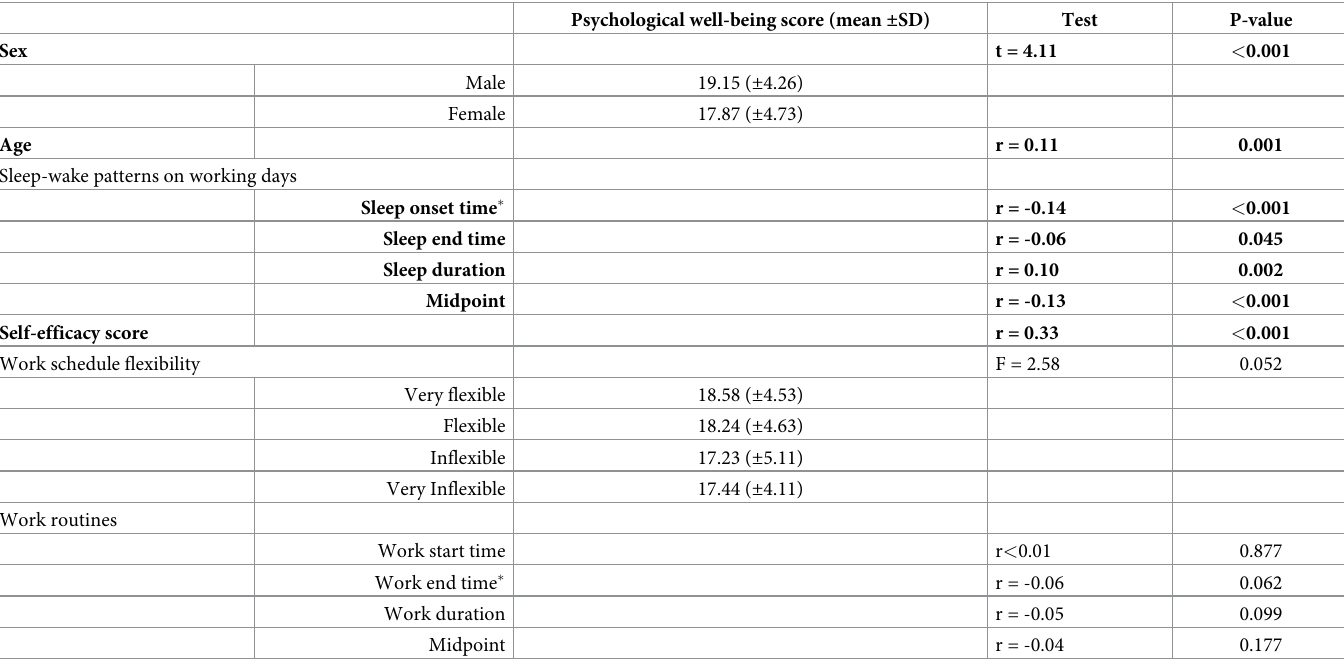
Table 2. Univariate analysis for the association between the studied variables and psychological well-being scores (N = 987). Psychological well-being score (mean ± SD) Test P-value t =